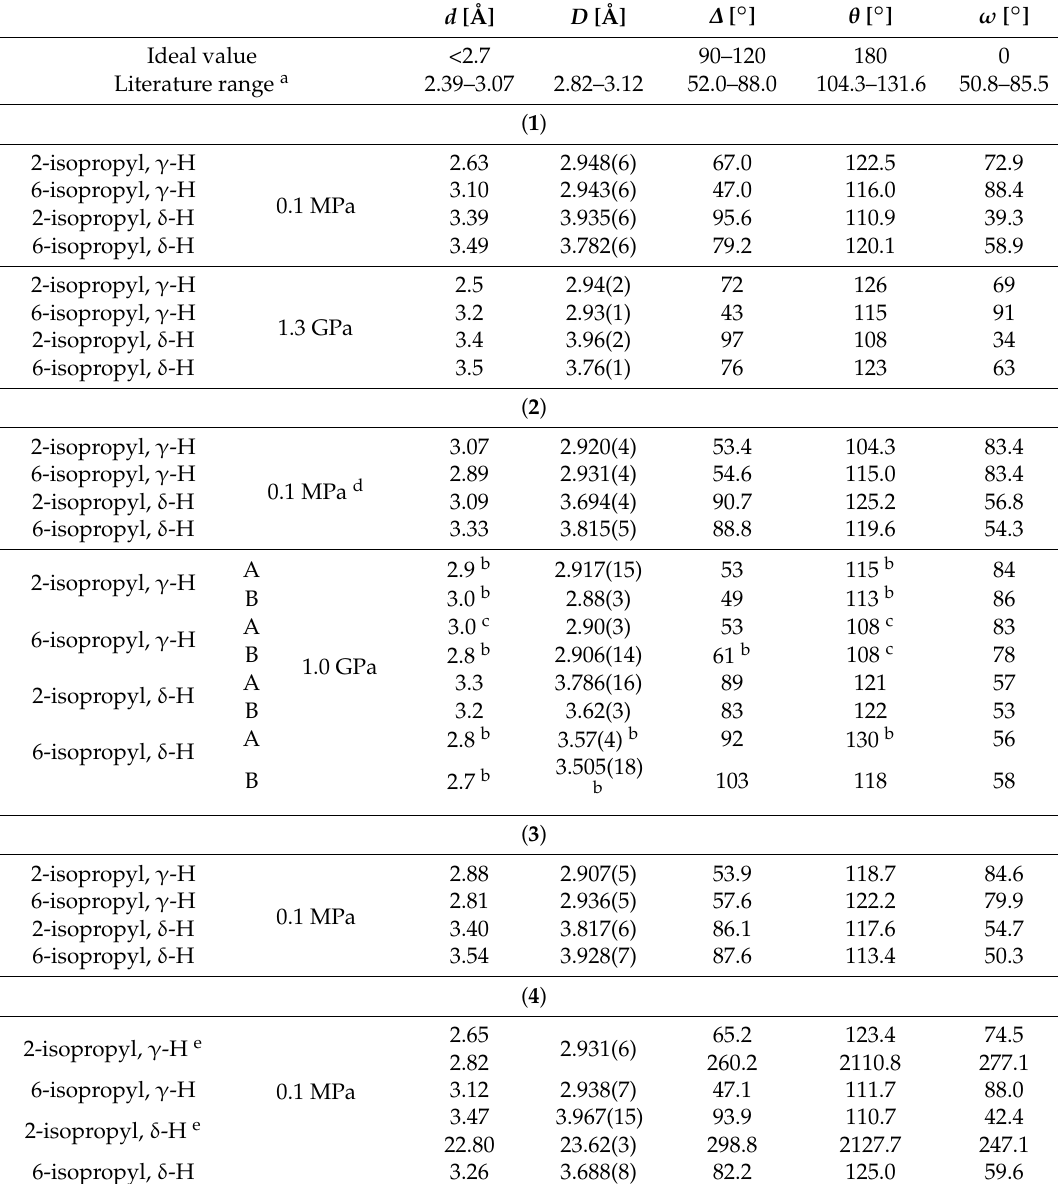
Table 3. The values of the intramolecular geometrical parameters describing susceptibility to the Norrish–Yang